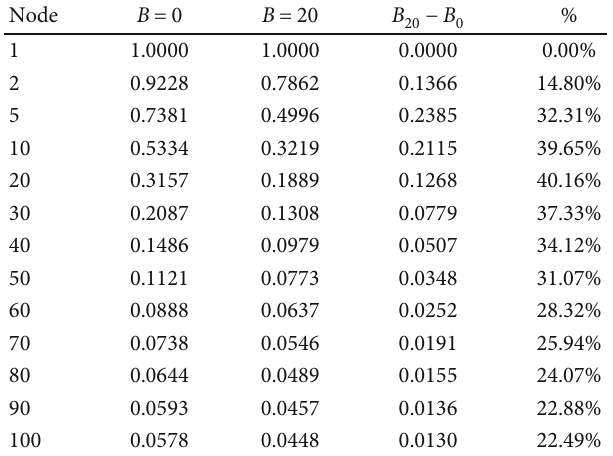
Table 1: Comparison of radiation values B = 20 :